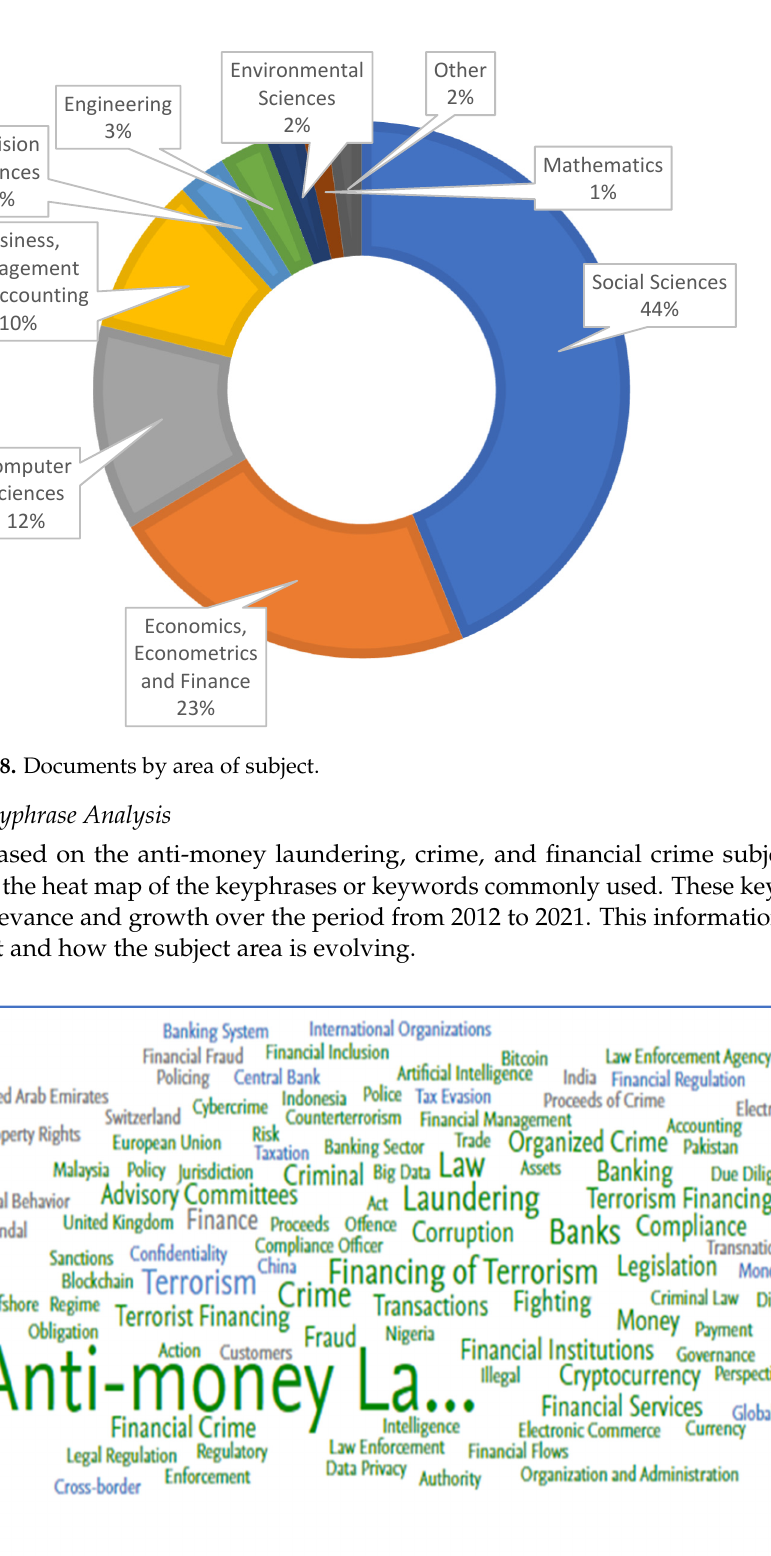
12 of 17 Figure 7. Publication source distribution. 4.2.8. Documents by Subject Area